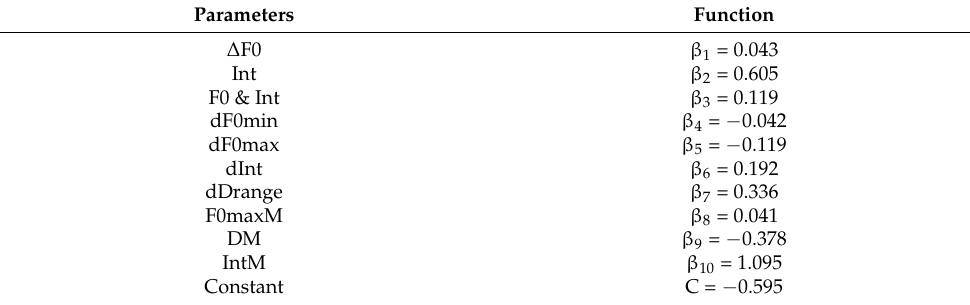
Table 6. Canonical Discriminant Function Coefficients.